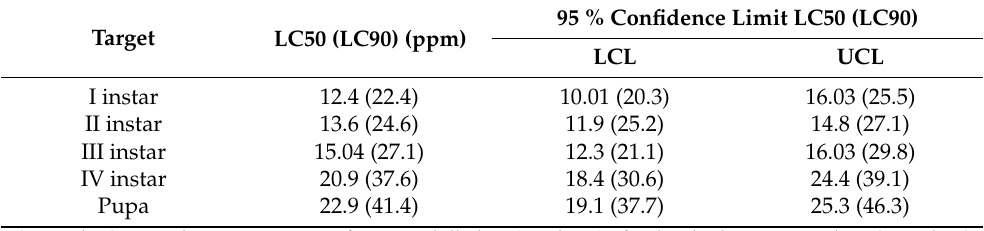
Table 1. The toxicity of Ag-NPs fabricated by A. niger strain F2 against various instar larvae and pupae of A. aegypti .